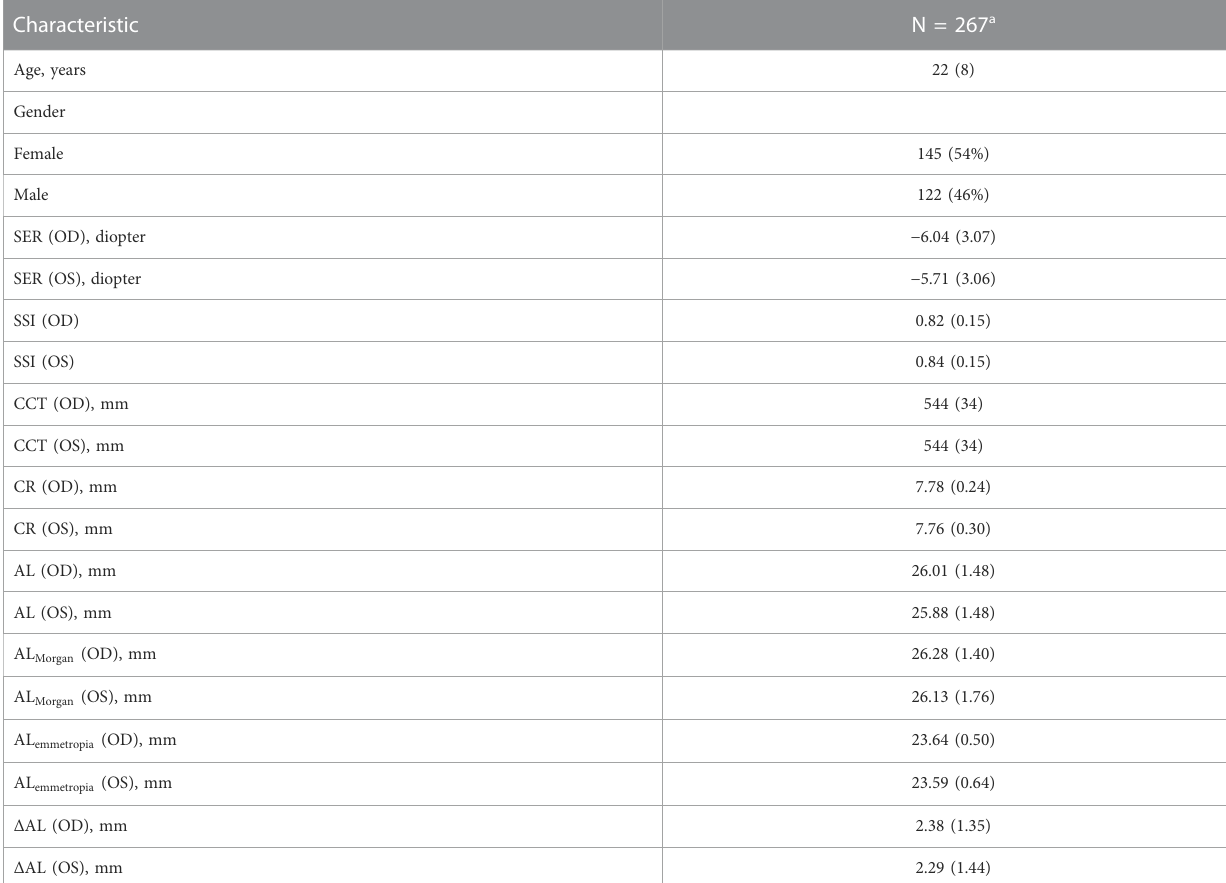
TABLE 1 Characteristics of our study